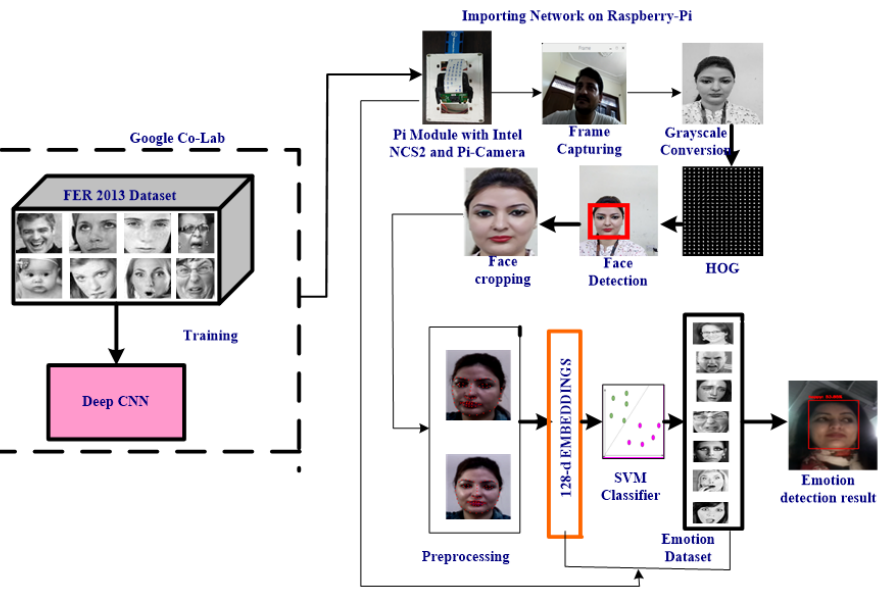
Figure 2. Architecture for face recognition and facial emotion recognition in real-time using Rasberry-Pi and Intel Movidius NCS2.